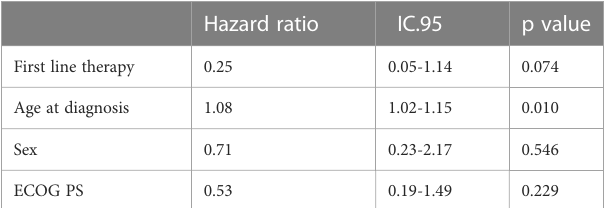
TABLE 4 Competing risk analysis by Fine and Gray